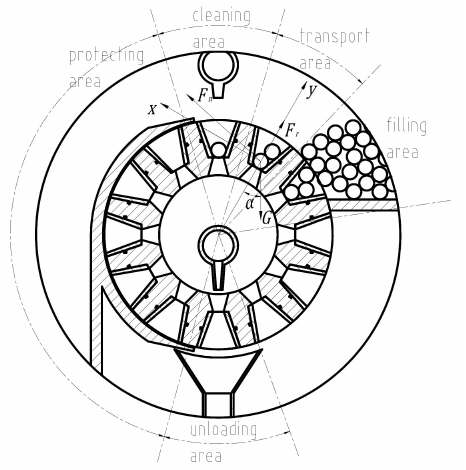
Figure 3. Sketch map of seed stress during transportation.